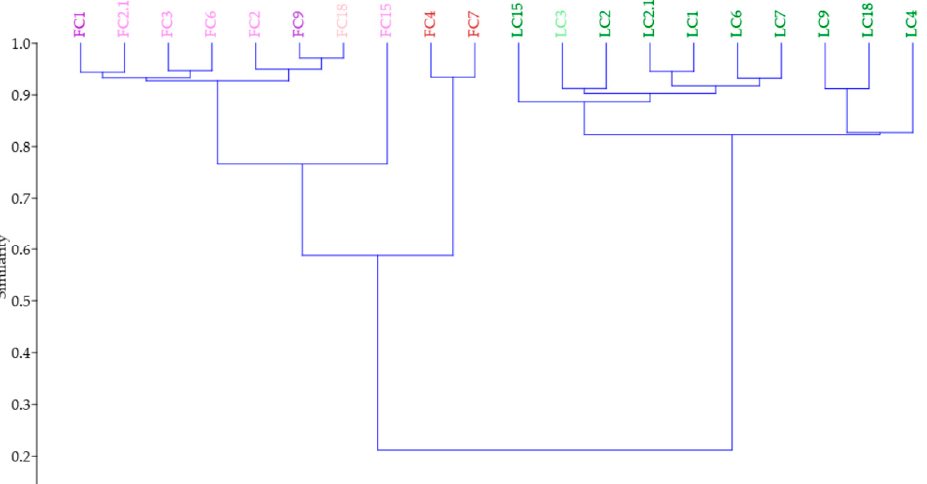
Figure 8. HCA of the Cyclamen genotypes based on isolated compounds and biological activities (Bray–Curtis similarity, R = 0.99) .